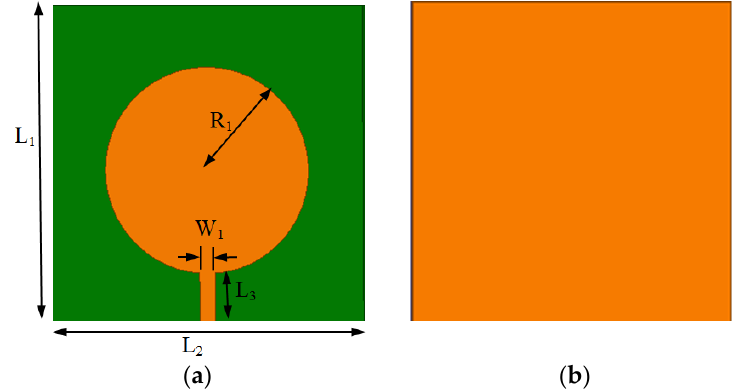
Figure 1. Structure of the proposed circular patch antenna ( a ) top view ( b ) bottom view. Table 1. Design parameters of the proposed antenna.